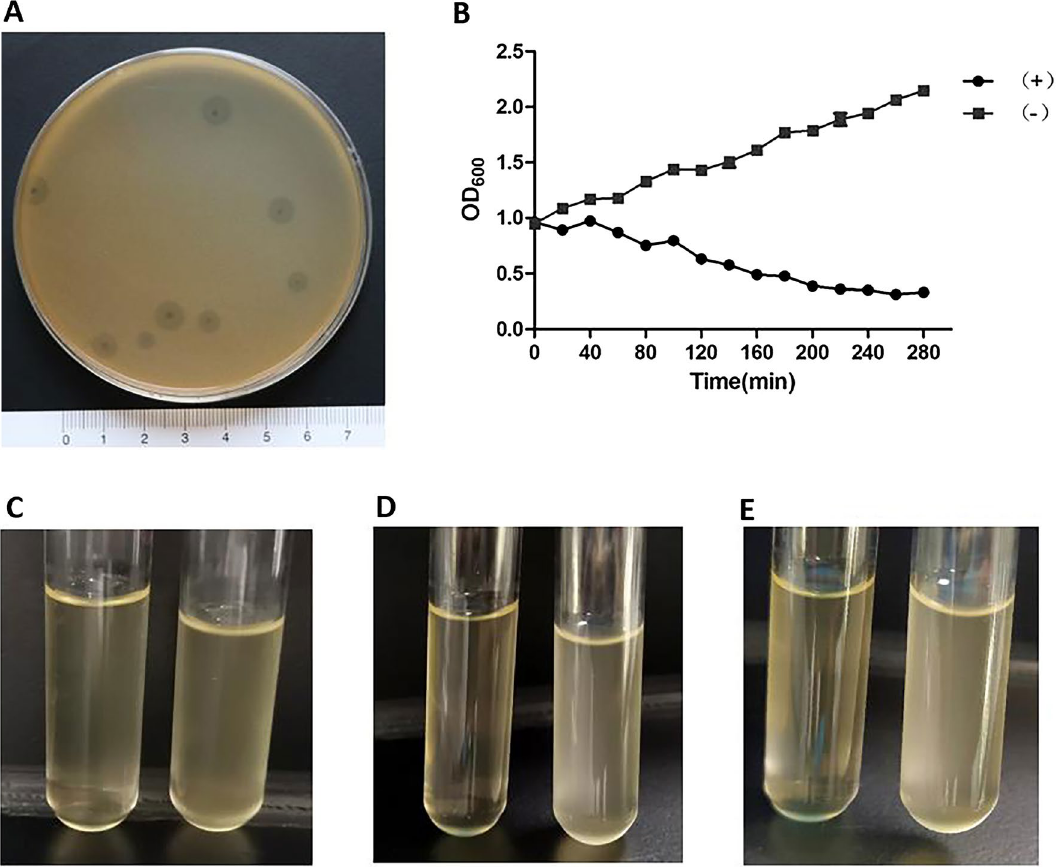
Figure 1. Lytic activity of Abp95 phage on A. baumannnii sensitive strain AB 2013-95 . ( A ) Abp95 plaques formed in a double-layer agar plate after infection of the AB 2013-95 host; ( B ) Graphic of measured OD 600 values of AB 2013-95 bacterial culture during the time with (+) or without (−) Abp95; ( C )–( E ) Abp95 cause lysis in a bacterial culture after incubation. (Phage was added to the left tube and equal PBS was added to the right tube, ( D ): 4 h after adding phage, ( E ): 6 h after adding phage).